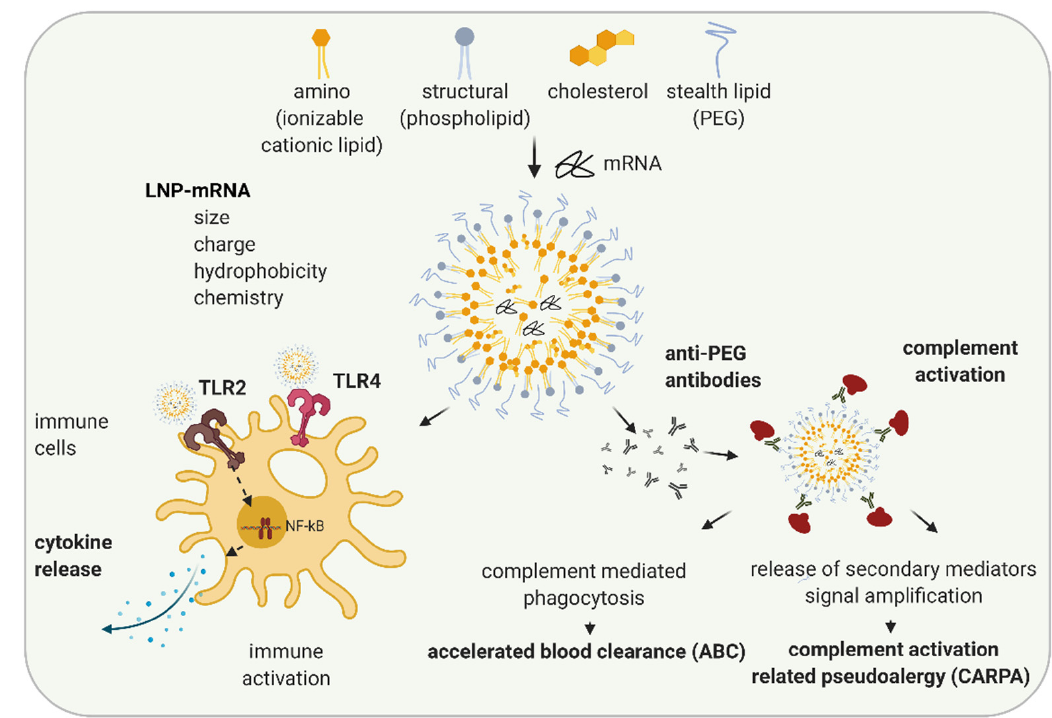
Figure 2. Schematic illustration of LNP-induced immune activation. The lipid nanoparticle (LNP) components, ionizable cationic lipids, structural, stealth lipids, and cholesterol, determine LNP particle size, charge, hydrophobicity, and chemistries. Depending on their features, LNPs can lead to immune activation by activating TLR2 and TLR4 and executing signal transduction pathways leading to NF-kB activation and cytokine secretion. When PEG-lipid is used as a stealth lipid, anti-PEG antibodies can be formed leading to complement activation and subsequently complement mediated phagocytosis resulting in accelerated blood clearance (ABC) phenomenon, or, in rare cases, the release of multiple secondary mediators may occur, leading to complement related pseudoallergy (CARPA). Created with